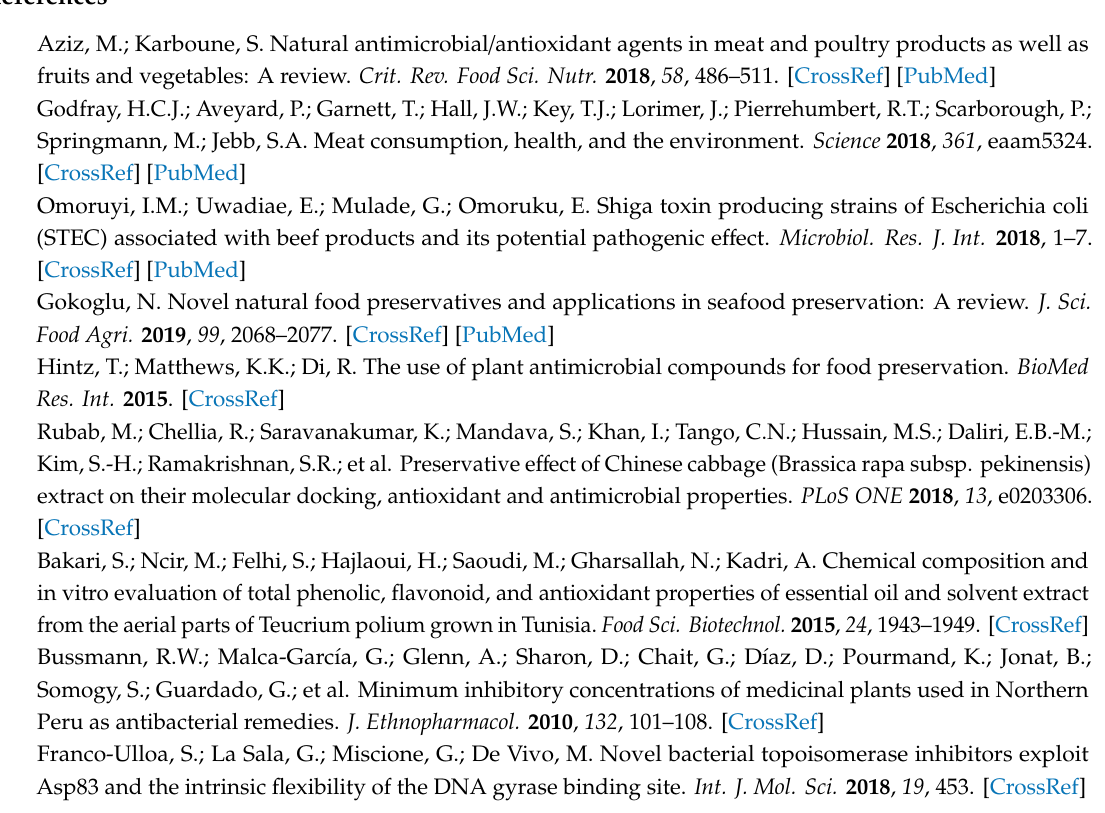
Figure S1: GC-MS chromatogram of RCC extract, Table S1: Quantitative phytochemical analysis of di ff erent extracts of RC, Table S2: Antimicrobial activity of the compounds present in